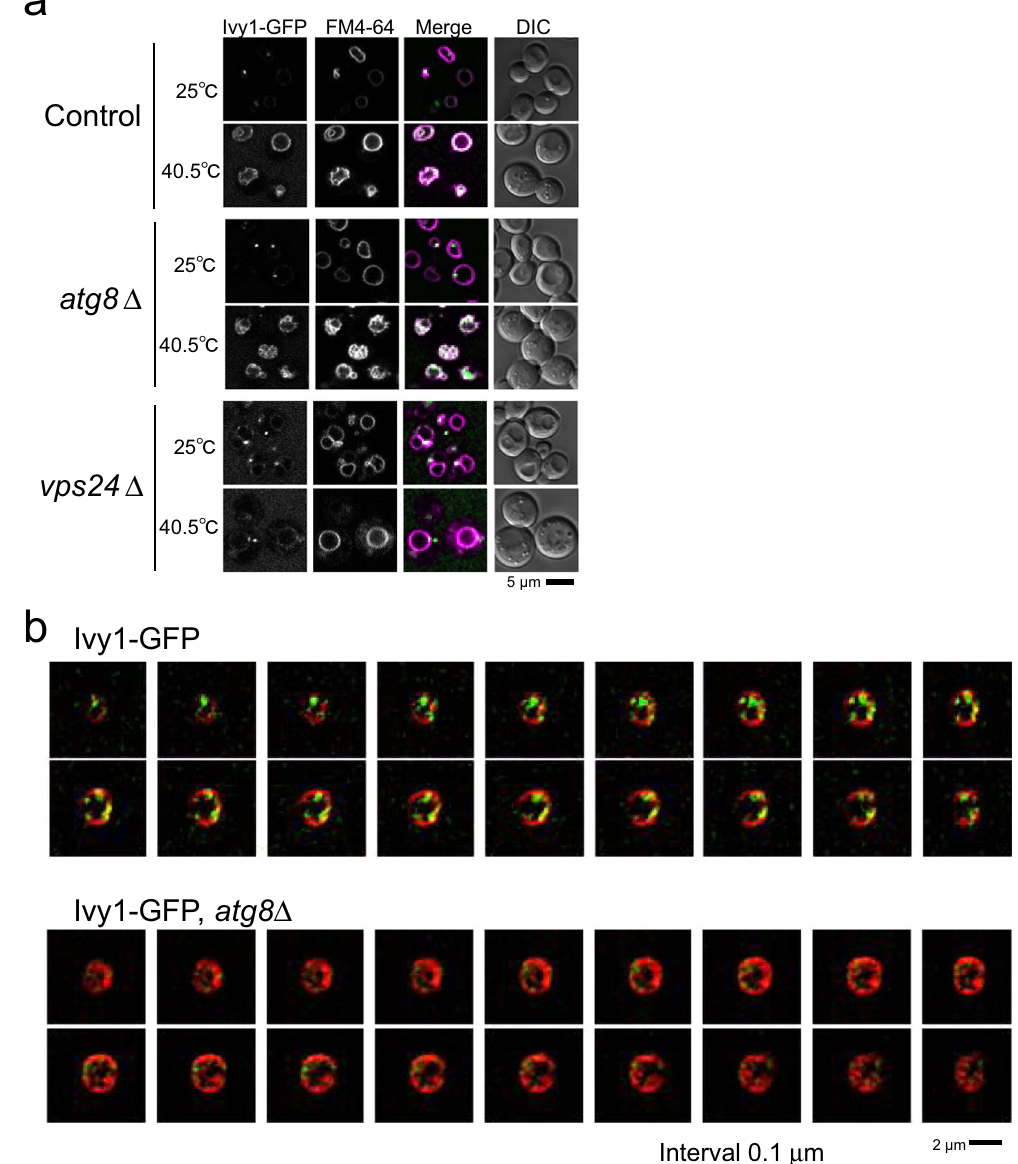
Figure 7. Localisation of Ivy1-GFP. ( a ) Localisation of Ivy1-GFP expressed in control, atg8 Δ , vps24 Δ cells incubated at 25 °C and at 40.5 °C for 4 h. Images were taken by SCLIM. ( b ) Z-stack analysis of Ivy1-GFP in control, atg8 Δ , and atg8 Δ ivy1 Δ cells incubated at 40.5 °C for 4 h. Merged images of GFP and FM4-64 fluorescence are shown. The images were taken by SCLIM. Scale bar, 2 μ